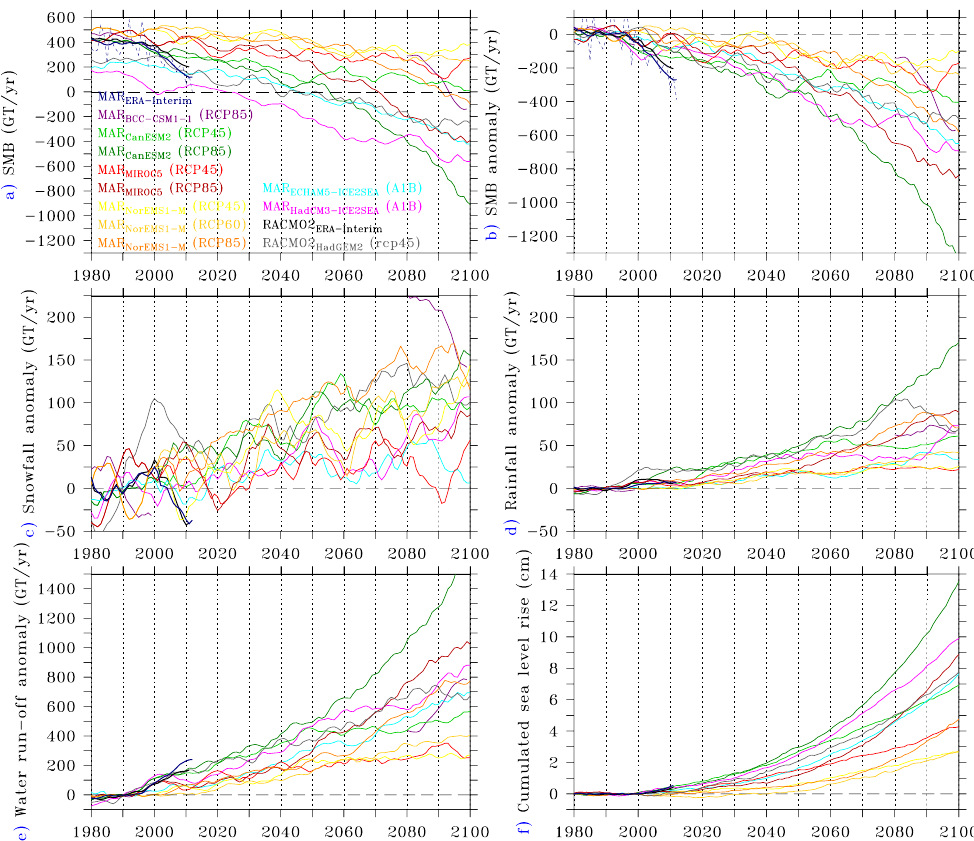
Fig. 4. (a) Time series of the annual total ice sheet SMB (in GTyr − 1 ) simulated by MAR and RACMO2 forced by the listed GCMs over 1980–1999. (b) Same as (a) but for the SMB anomaly with respect to 1980–1999. (c) Same as (b) but for the snowfall. (d) Same as (b) but for the rainfall. (e) Same as (b) but for the JJA near-surface temperature averaged over the GrIS. (f) The corresponding cumulated sea level rise (in cm) from SMB changes. The computations use an ocean area of 361millionkm 2